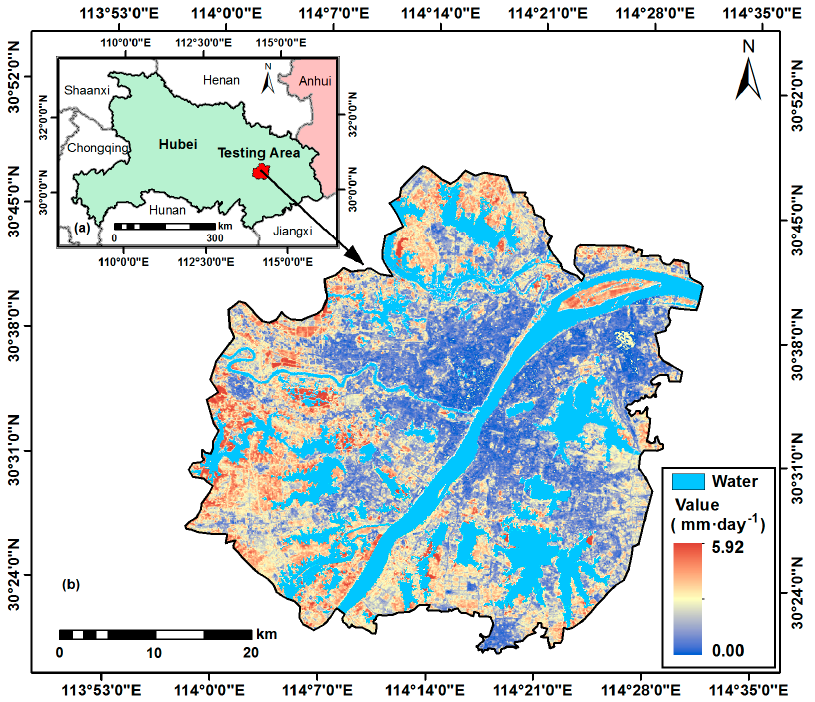
Figure 18. ( a ) The testing area of Wuhan in Hubei province; ( b ) the spatial variability of daily evapotranspiration of Wuhan’s urban built-up area on 8 August 2013, inferred from our modified model.